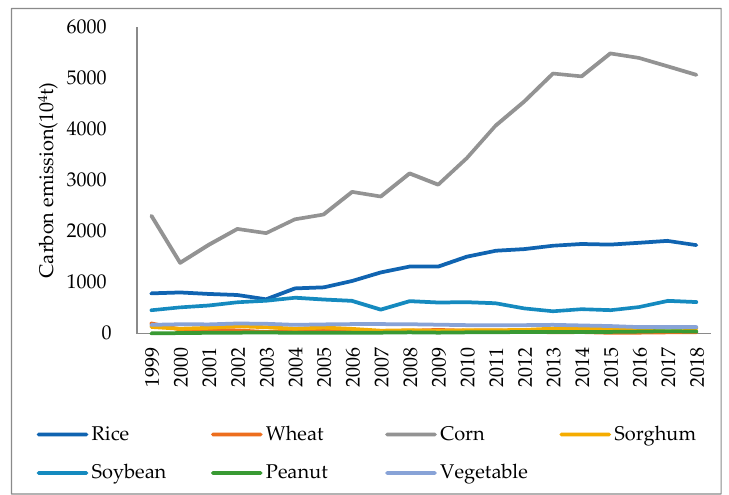
Figure 2. Crop composition of carbon emission from crop straw burning. Data Source: calculated by the authors.